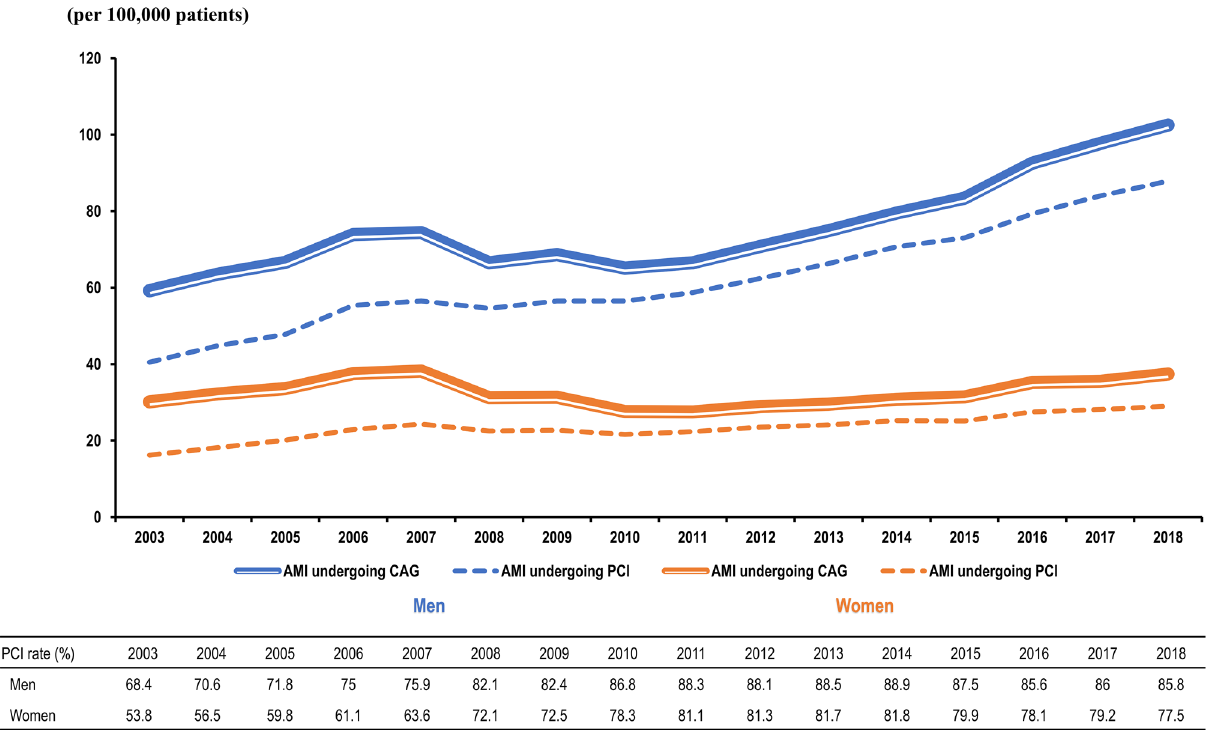
Figure 3. Incidence of AMI undergoing CAG and patients who underwent PCI from 2003 to 2018 according to the Korean National Health Insurance Claims Database. The PCI rate was defined as the proportion of patients diagnosed with AMI who underwent PCI against the number of patients diagnosed with the disease and undergoing CAG. Abbreviations: AMI, acute myocardial infarction; CAG, coronary angiography; PCI, percutaneous coronary